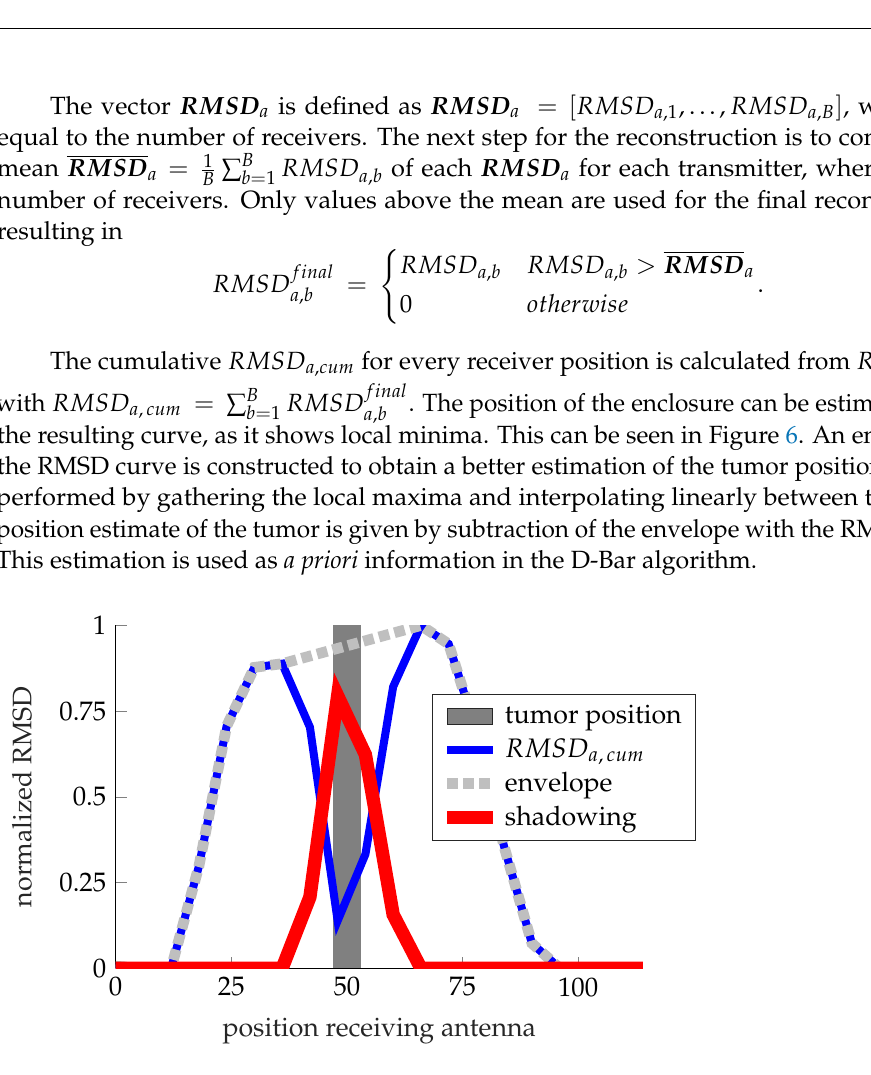
Figure 6. Reconstruction of two tumors using the reconstruction algorithm described. The RMSD curve can be seen. The gray dashed line is the envelope that aids in the calculation of the estimated tumor position, which is the red line—adapted from [24]. The position of the tumor along the y-axis is 27.5 mm and it has a diameter of 8 mm .